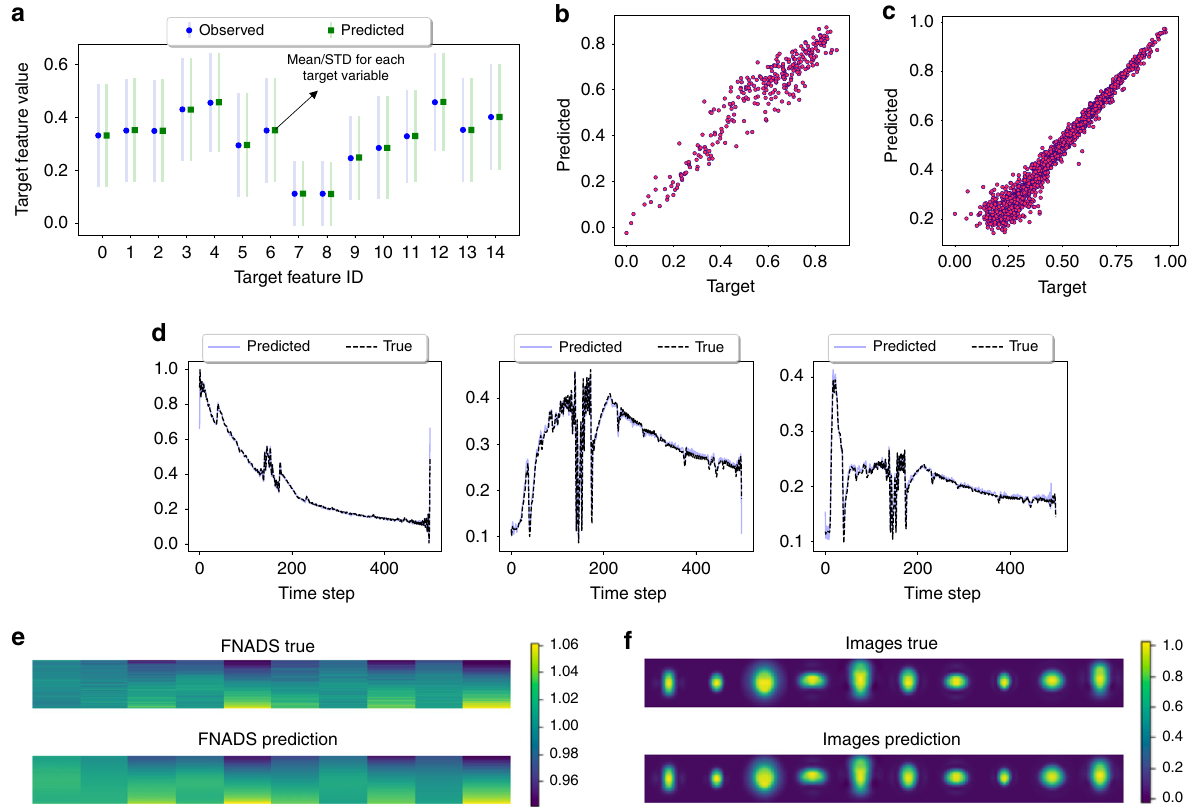
Fig. 3 Qualitative evaluation of Learn-by-Calibrating (LbC) predictions. Predictions obtained using the proposed approach on different use cases: a ICF JAG — we show the distribution of values for each of the target variables and the corresponding predictions. b Airfoil self-noise. c Electric grid. d Reservoir model — reconstructions from the decoder. e – f FNADS and image predictions from the decoder for ICF Hydra. Across benchmarks of varying dimensionality and complexity, LbC produces high- fi delity emulators that can be reliably used in scienti fi c work fl